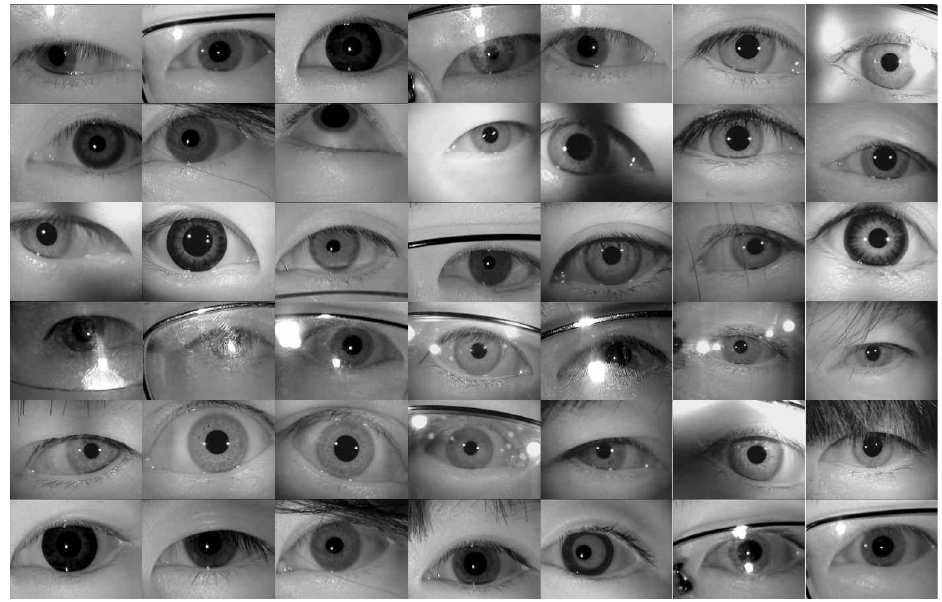
Figure 8. An example of eye images in Dataset II. The meanings of the parameters used in our experiment are shown in Table 1. Table 1. Parameters used in the experiment and their